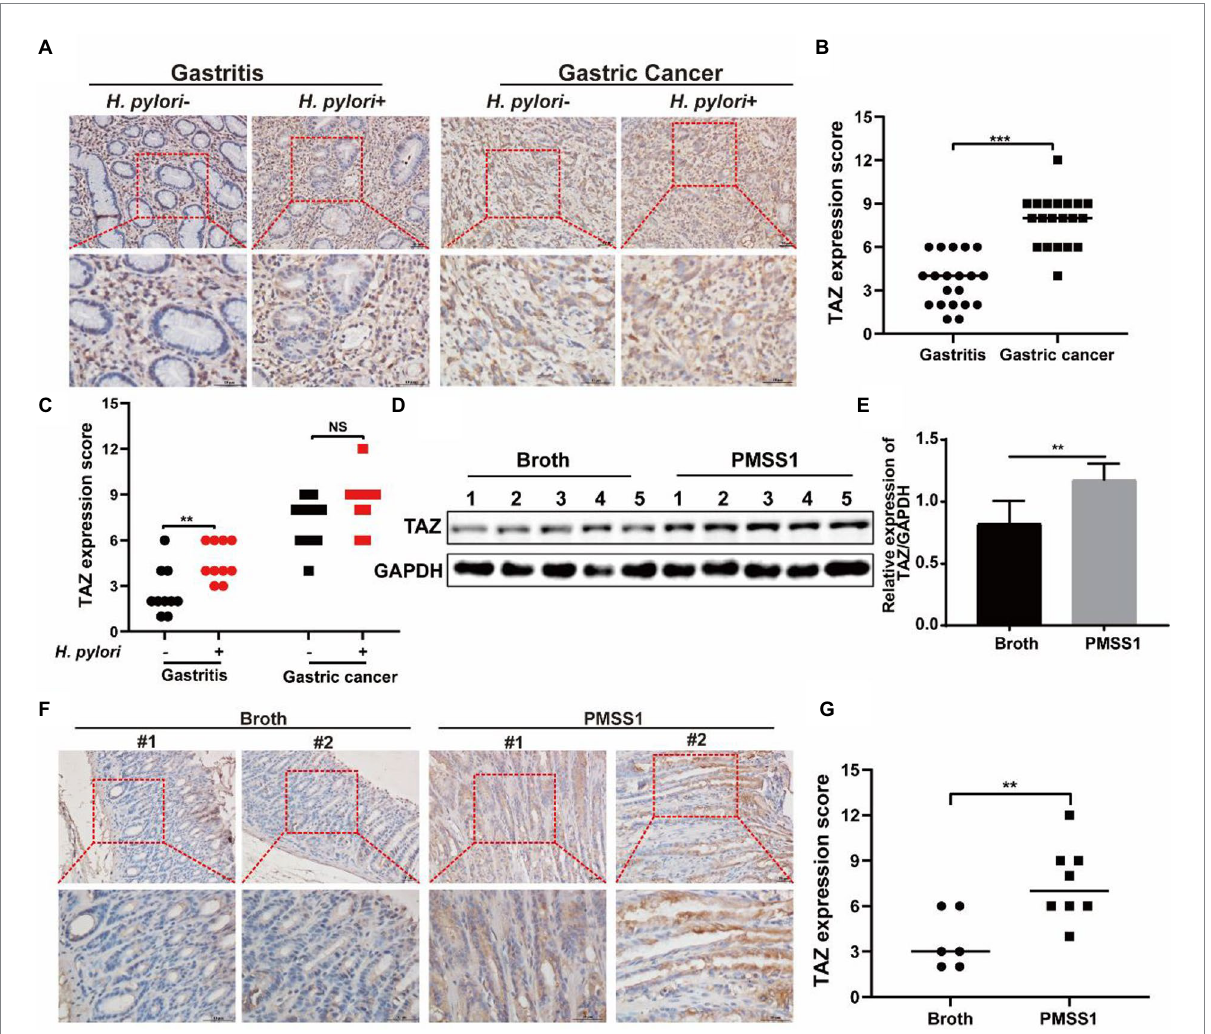
FIGURE 1 TAZ expression levels in human gastric tissues and INS-GAS mice infected with H. pylori PMSS1. (A) Immunohistochemistry for TAZ expression in human chronic gastritis and gastric cancer tissues. Representative images of TAZ (magnification 200× and 400×, scale bars =50 μ m). (B) Quantitative analysis of TAZ expression in all cell types in gastritis and gastric cancer tissues from both H. pylori -negative and H. pylori -positive subjects. (C) Quantitative immunohistochemistry analysis of TAZ levels in H. pylori -positive or H. pylori -negative gastric tissues. (D) Western blot of TAZ protein expression in gastric tissues of INS-GAS mice infected with H. pylori PMSS1 strain or Brucella broth treatment. (E) Statistical analysis of the intensity of western blot bands. (F) Immunohistochemistry staining for TAZ expression in the H. pylori -infected INS-GAS mice. Representative images of TAZ (magnification 200× and 400×, scale bars =50 μ m). (G) Quantitative analysis of TAZ levels. **p < 0.01, ***p < 0.001, NS , not significant. Scare bars in (A,E) , 10 μ